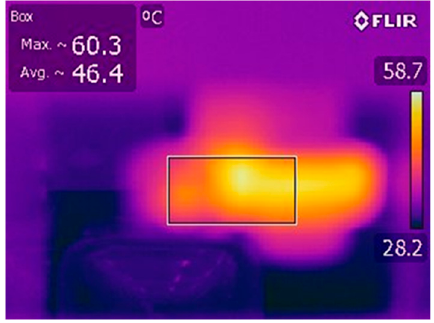
Figure 8. The temperature field in the area of the cast iron sample–granite roller interface during the wear test on the Baroid tester.